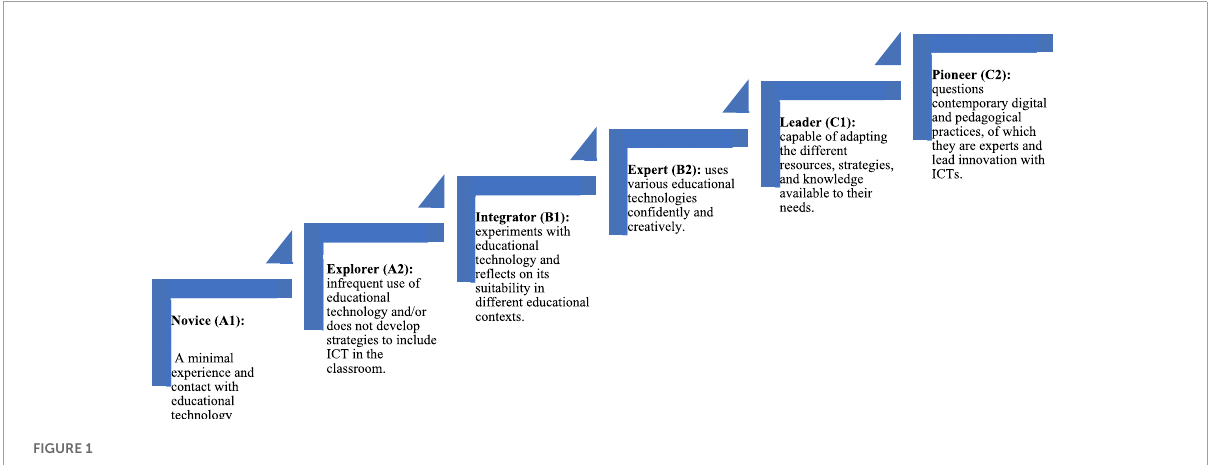
FIGURE1 Levels of digital teaching